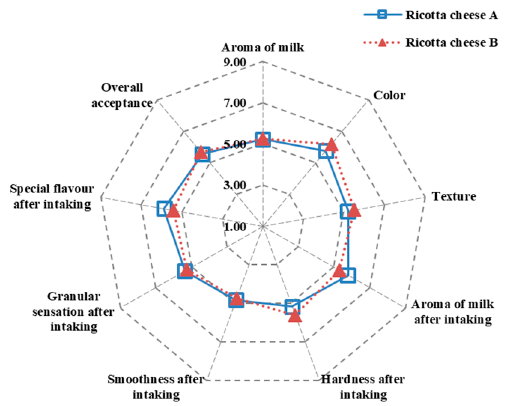
Figure 6. Preference sensory evaluation of ricotta cheeses A (80/20 cow cheese whey/skimmed goat milk) and B (80/20 cow cheese whey/full-fat goat milk).